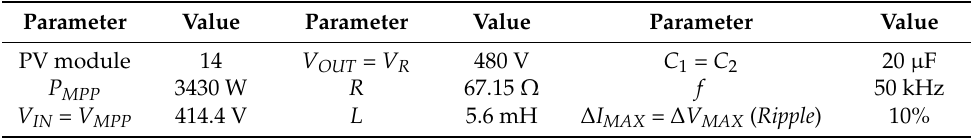
Table 2. Parameters of the buck–boost converter by scenario.